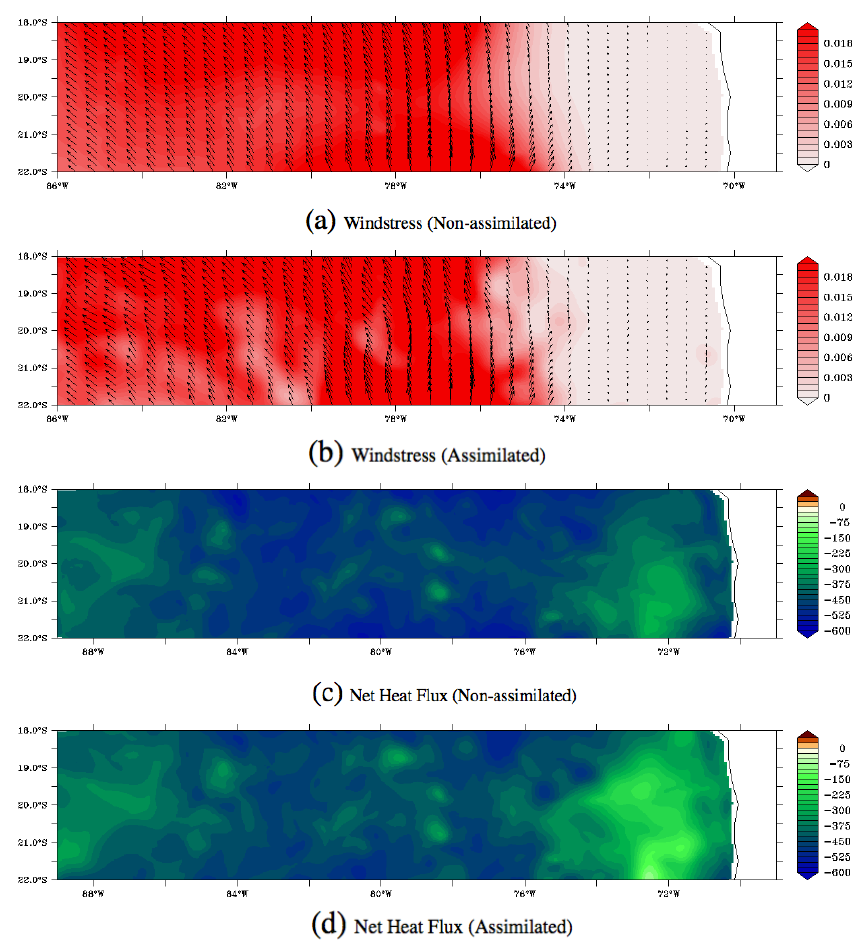
Fig. 7. Windstress (Nm − 2 ) forcing for the ROMS model for the period from 1–15 November 2008 before (a) and after (b) adjustment from assimilation of observations. Net Heat flux (Wm − 2 ) forcing for the ROMS model for the period from 1–15 November 2008 before (c) and after (d) adjustment from assimilation of